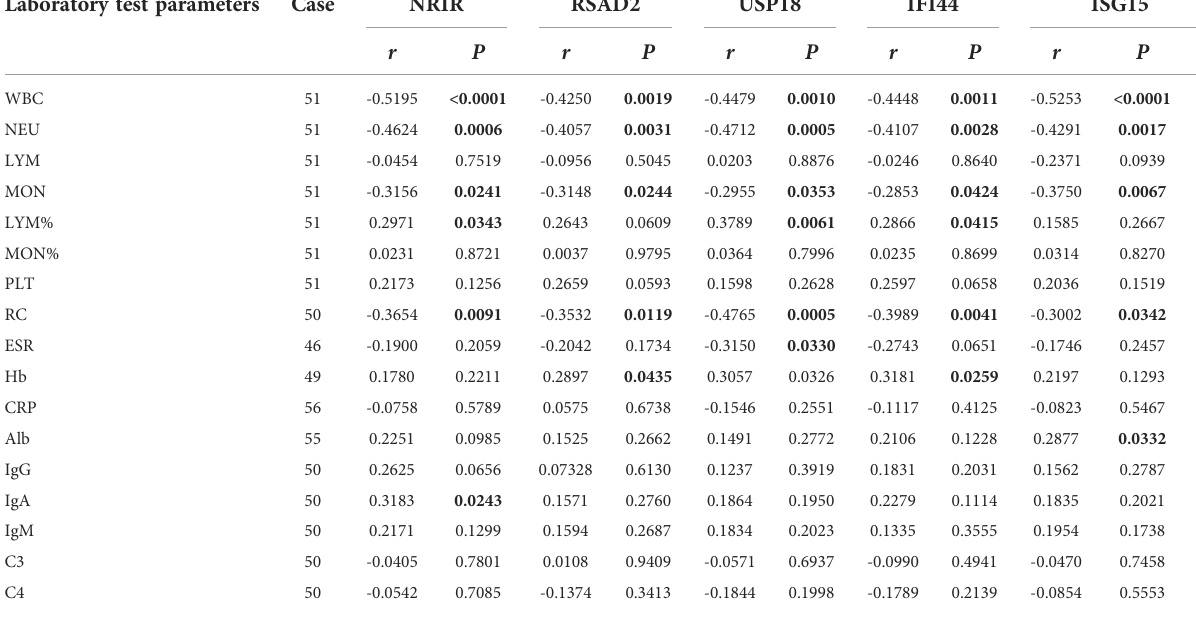
TABLE 6 The correlations between the relative expressions of ISGs and laboratory test